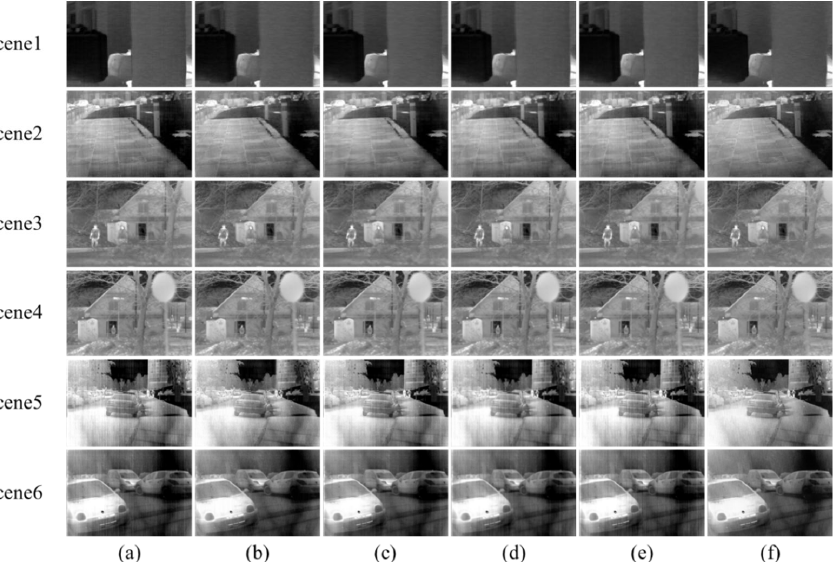
Figure 14. The NUC results of different methods. ( a ) The raw images; ( b ) 1DGF [33]; ( c ) SNRCNN [15]; ( d ) DLS-NUC [16]; ( e ) ICSRN [17]; ( f ) Our method.